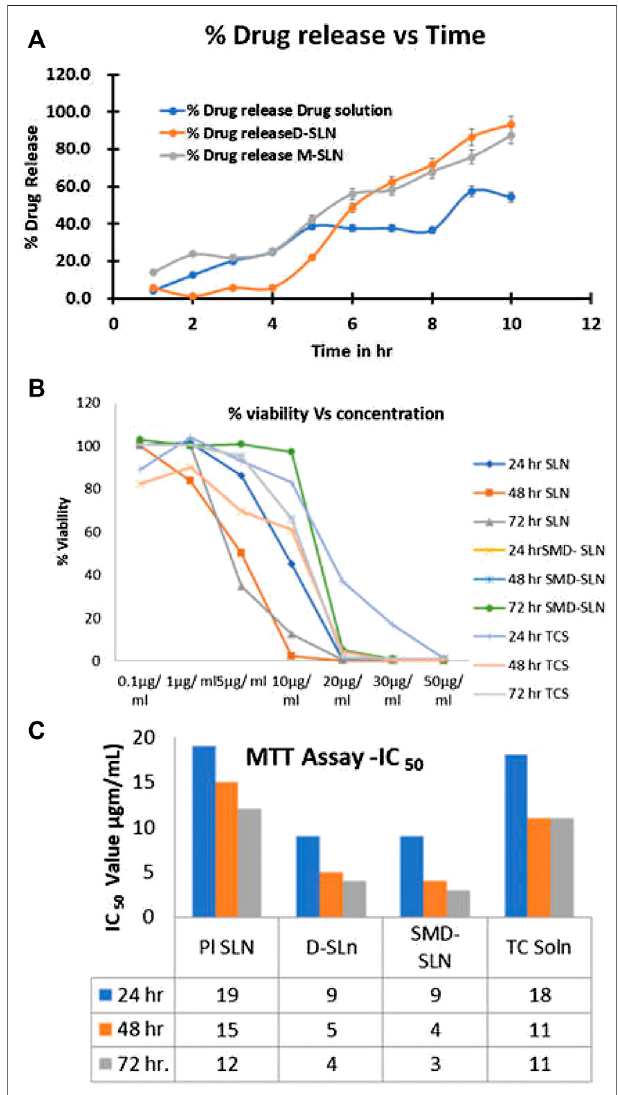
FIGURE 4 | In vitro drug release pro fi le (A) , cell viability (B) , and IC50 graph of developed SLN